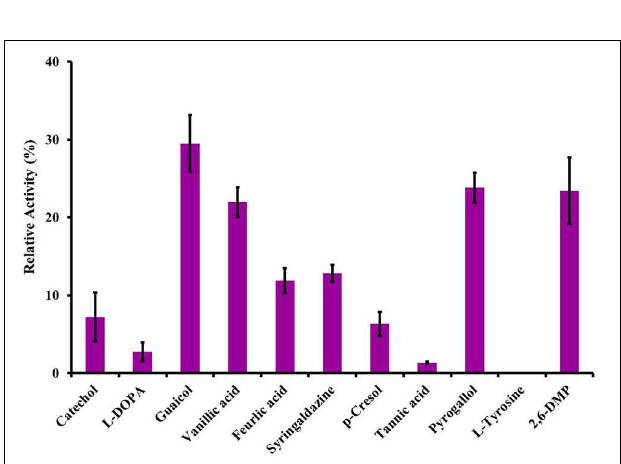
FIGURE 5 | Kinetics of glucose utilization, biomass and laccase production by H. hirta. Initial substrate concentration 10.5g.L − 1 culture MSF2 was incubated in GY medium with optimal CuSO4 and 2,5 Xylidine. Error bars indicate standard deviations of triplicate experiments.